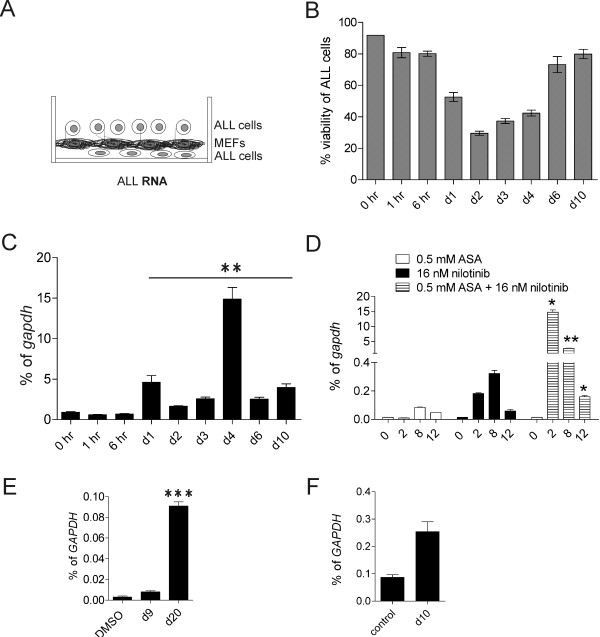
Real time RT/PCR expression of cassini in pro-B ALL cells treated with therapeutic drugs in the presence of direct stromal support. (A) Schematic representing the nature of a co-culture system in which ALL cells and stromal cells are in direct contact with one another. Due to partial infiltration of ALL cells underneath the stromal layer, only ALL cells in the supernatant were harvested for RNA isolation and gene expression purposes. (B) Viability of murine 8093 ALL cells over the course of drug treatment in the presence of MEFs. (C) Real time RT/PCR analysis of cassini expression in 8093 ALL cells at indicated time points during drug treatment (n = 3). **p < 0.01 d1-d10 compared to 0 hr. (D) 8093 cells treated with ASA, nilotinib or nilotinib + ASA (n = 2). ASA + nilotinib on d2, d8 and d12 versus nilotinib on d2, d8 and d12 *p < 0.05, **p < 0.01 and *p < 0.05, respectively. (E, F) Expression of CASSINI in human ALL cells in direct co-culture with irradiated OP9 stromal cells (n = 1 each) and treated with (E) 2.5 nM vincristine over the course of 20 days, with US7 cells harvested at indicated time points, day 9 and day 20 or (F) TXL2R cells cultured for 24 days without nilotinib (control), or cultured for 14 days without nilotinib, then treated with 500 nM nilotinib for 10 days. Values are represented as mean ± SD of duplicate real-time RT/PCR. ***p < 0.001 US7 d20 vincristine compared to DMSO; p = 0.06 (ns) TXLR control compared to TXLR2 d10 nilotinib.